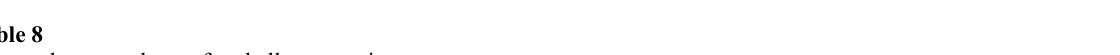
Group statistics for enjoyment motives Intrinsic enjoyment motives